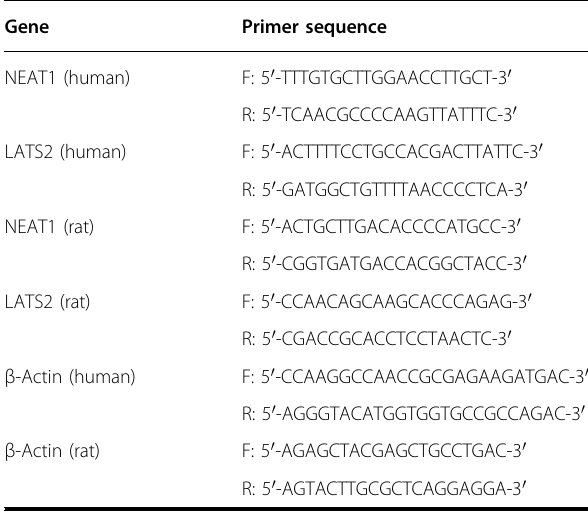
Table 1 Primer sequences for